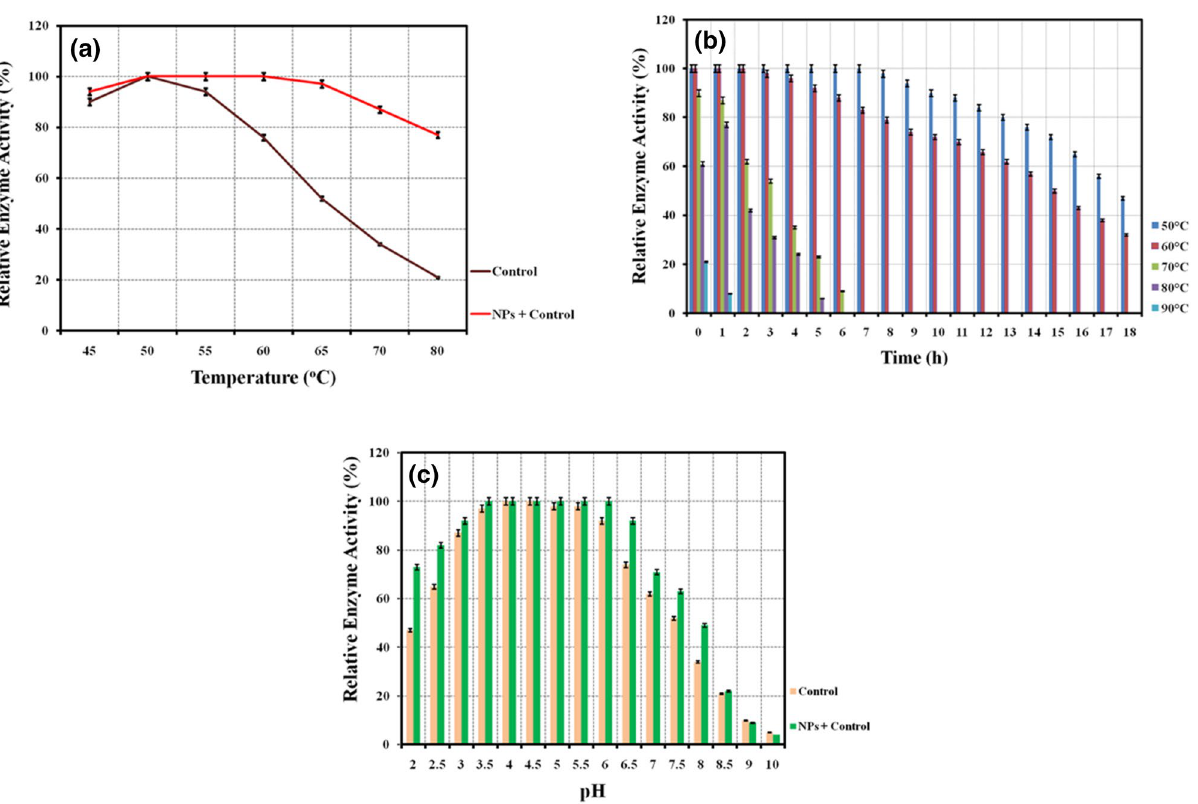
Figure 6. Graph shows thermal stability of enzyme for 1 h in presence of 0.5% concentration of Fe 3 O 4 /α- F 2 O 3 nanocomposite ( a ) thermal stability of enzyme in presence of 0.5% concentration of Fe 3 O 4 /α-F 2 O 3 nanocomposite for 0–18 h ( b ) pH stability of enzyme in presence of 0.5% concentration of Fe 3 O 4 /α-F 2 O 3 nanocomposite ( c